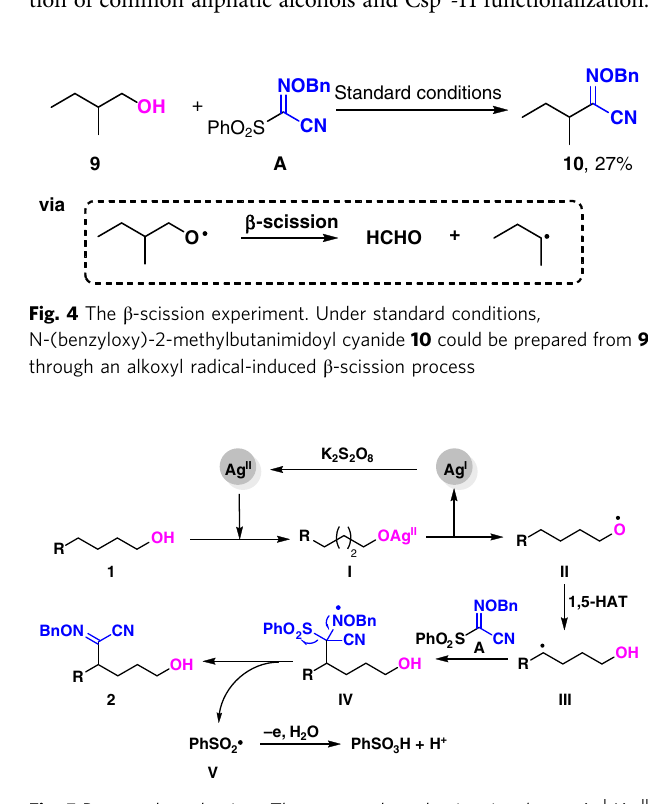
Fig. 5 Proposed mechanism. The proposed mechanism involves a Ag I /Ag